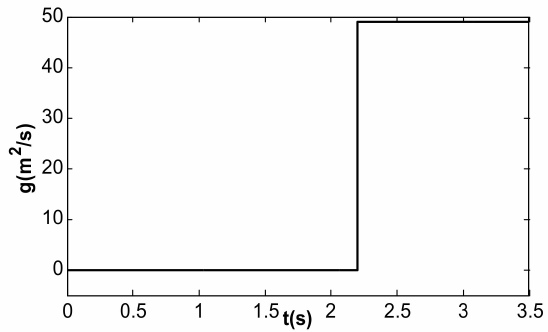
Figure 11. Loaded acceleration